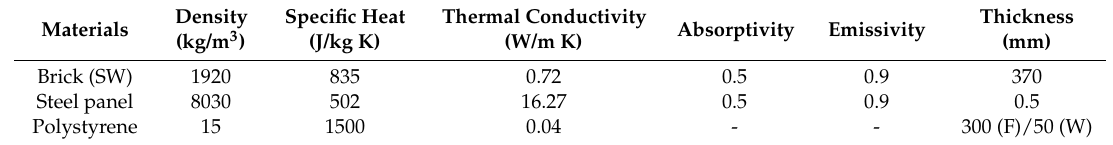
Figure 2. Views of the experimental system: ( a ) The horizontal cross-section schematic; ( b ) outside view showing the test room building. Table 2. Parameters characteristic of the building envelop.